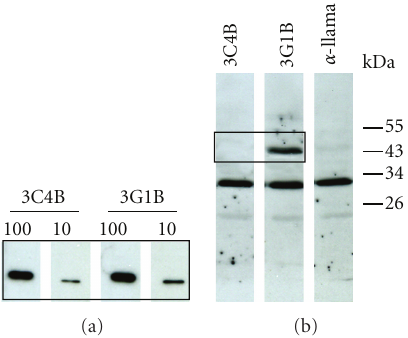
Figure 1: Application of anti-SNAP antibodies in western blot experiments. (a) Detection of 100 and 10ng of blotted purified recombinant GST-SNAP protein by means of the VHH antibodies 3C4B and 3G1B. (b) Detection of overexpressed GST-SNAP in bacterial total lysates using the same VHH antibodies. The secondary antibody anti-llama immunoglobulins used for detection recognized nonspecifically a further band of 32